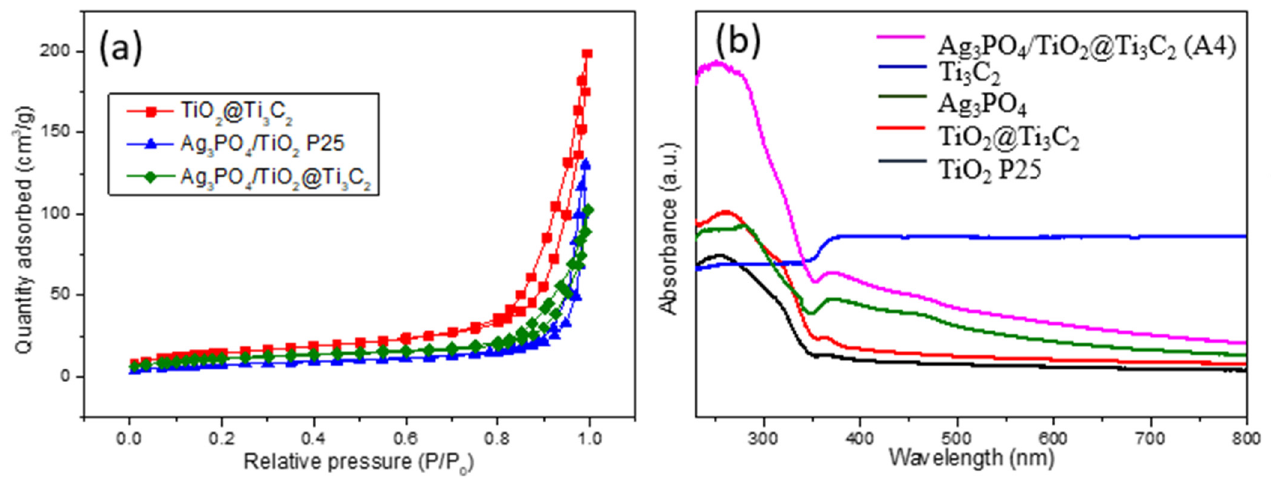
Figure 6. ( a ) BET surface area plot of TiO 2 @Ti 3 C 2 , Ag 3 PO 4 /P25, and Ag 3 PO 4 /TiO 2 @Ti 3 C 2 ; ( b ) UV-Vis DRS spectra of the as-prepared samples, including pristine TiO 2 P25, TiO 2 @Ti 3 C 2 , pure Ag 3 PO 4 , and